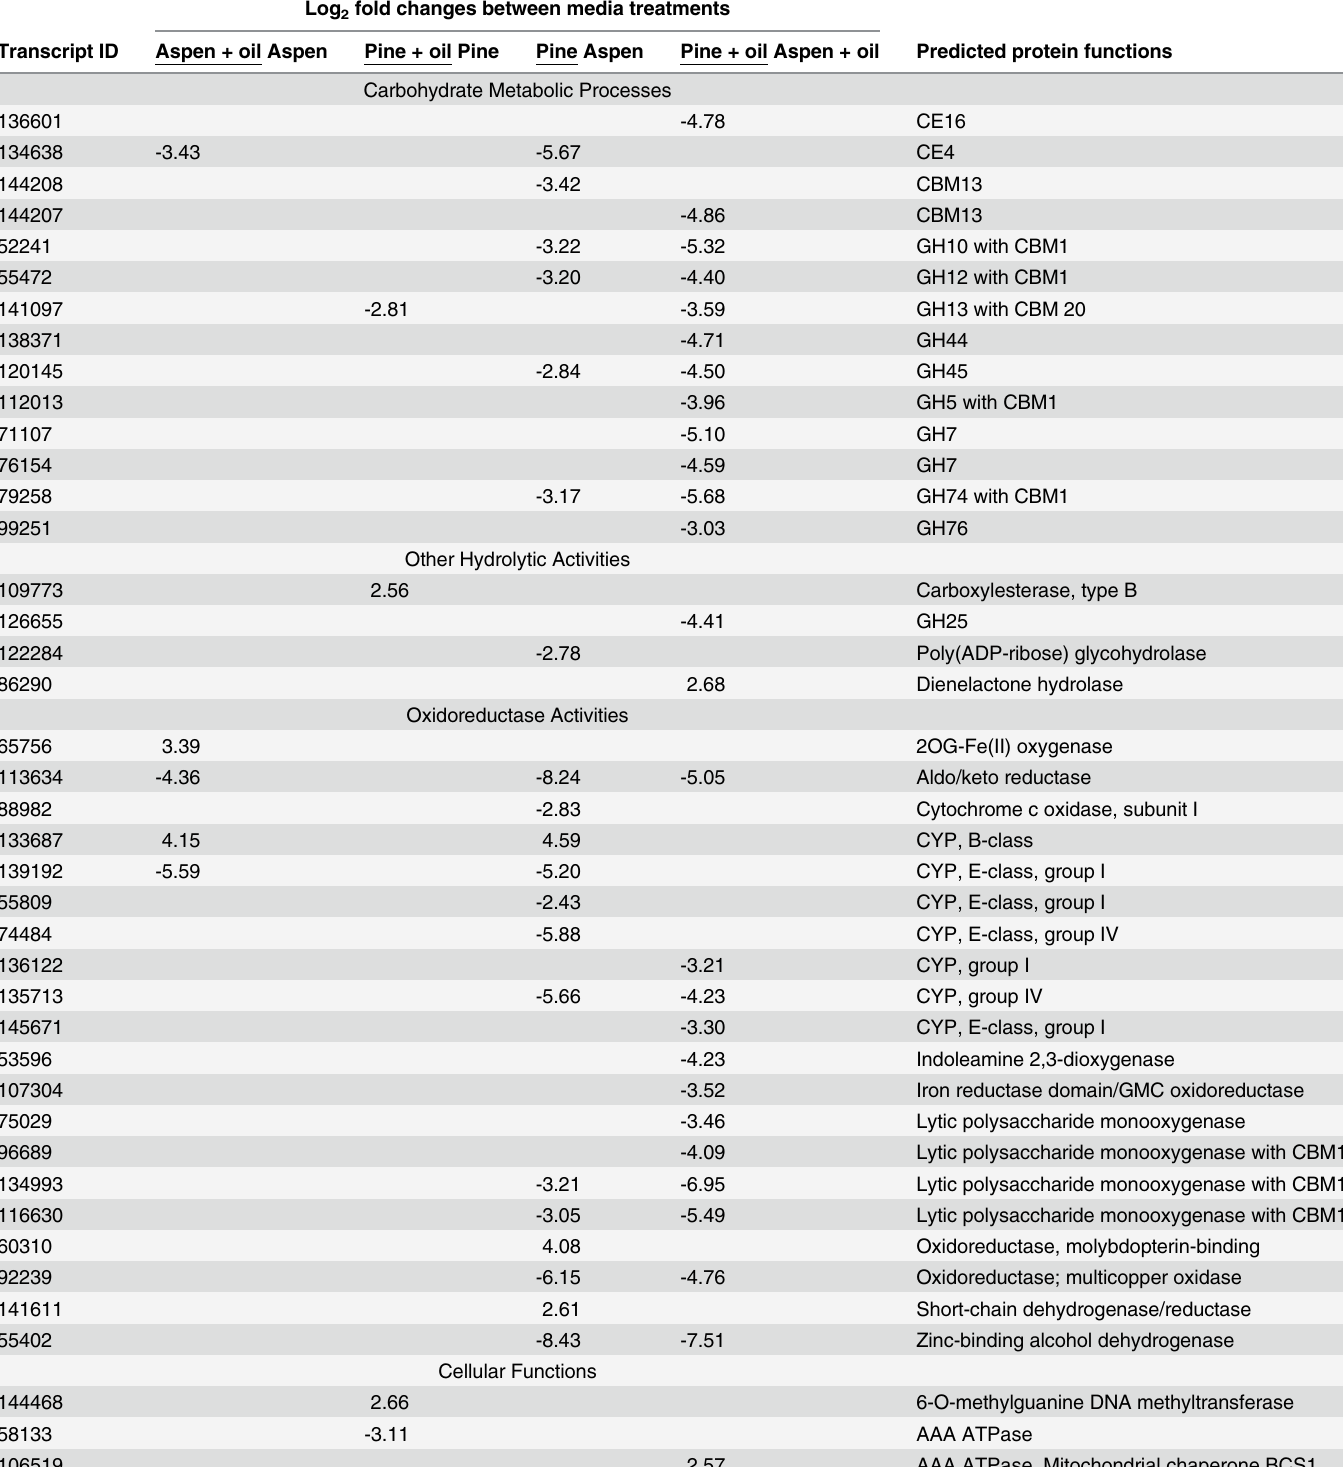
Table 3. Punctularia strigosozonata transcripts with predicted protein functions expressed (cid:1) log 2 (2-fold) (adjusted p < 0.01) in comparisons of 20-day growth on aspen and pine media with and without Bunker C oil. Log 2 fold changes between media